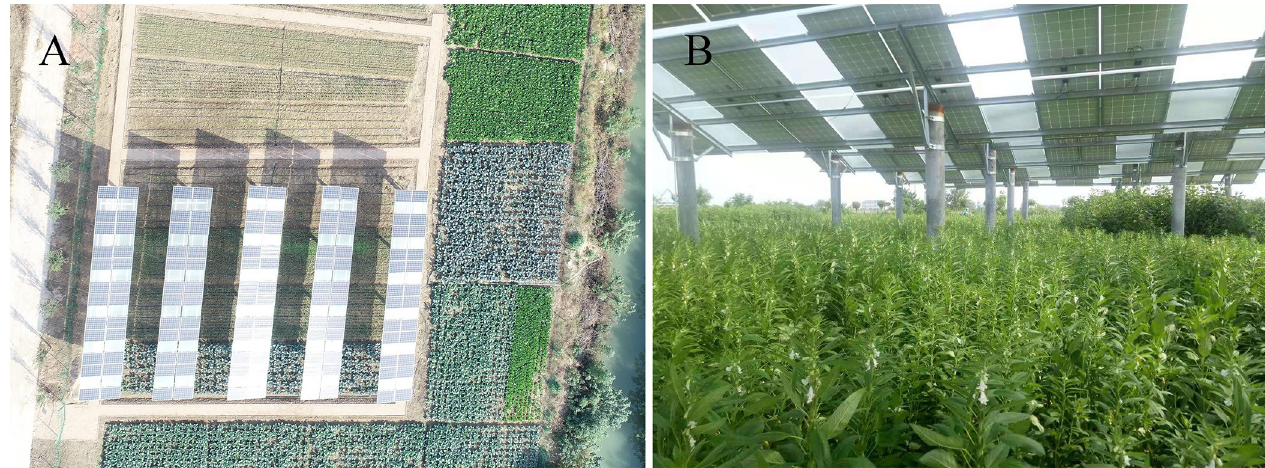
Fig 4. Photographs of the large-scale experimental facilities of the two treatments (T a , T b in Fuyang of Anhui, China). Aerial photograph of Fuyang Experimental Base (A). Details photograph under the EAS (B).